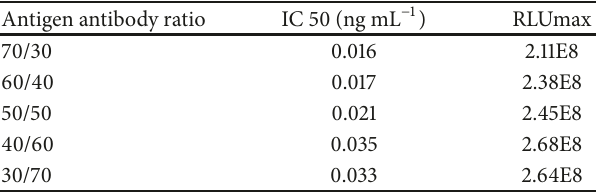
Table 2: Optimization of antigen antibody ratio.